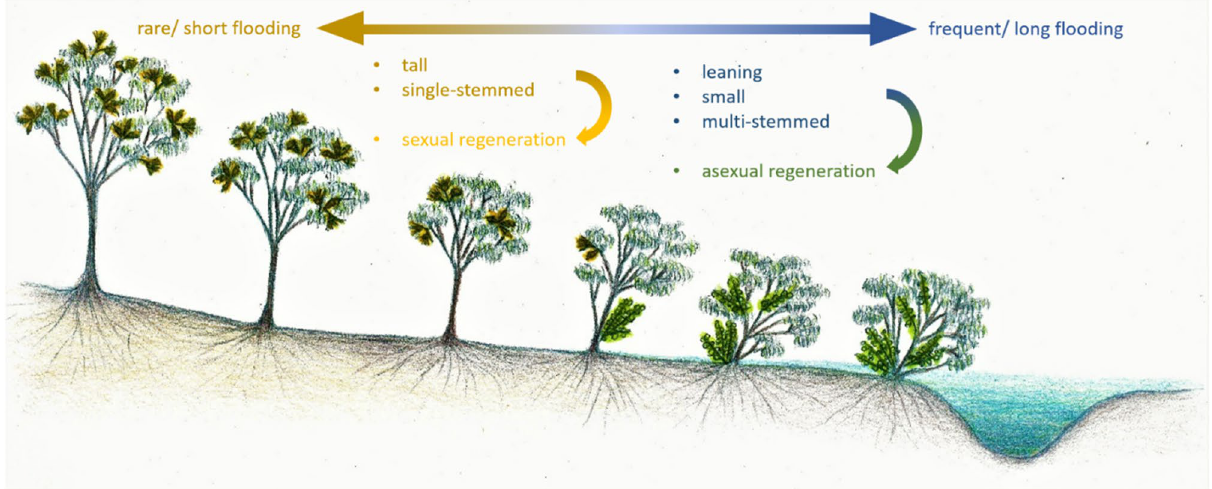
Figure 1. Hypothetical gradient in morphology and reproductive strategy of woody riparian plants in response to flood disturbance. Individuals that grow further from a channel or in higher elevations (left hand side) will experience less disturbance, i.e. shorter duration or less frequent flooding, which should hypothetically result in plants that are taller, single-stemmed and largely exhibit sexual or seed-based reproduction (symbolised by presence of flowers). In contrast, individuals that experience more disturbance (right hand side) will be more likely to have leaning stems, be shorter, multi-stemmed and reliant on vegetative reproduction (symbolised by epicormic